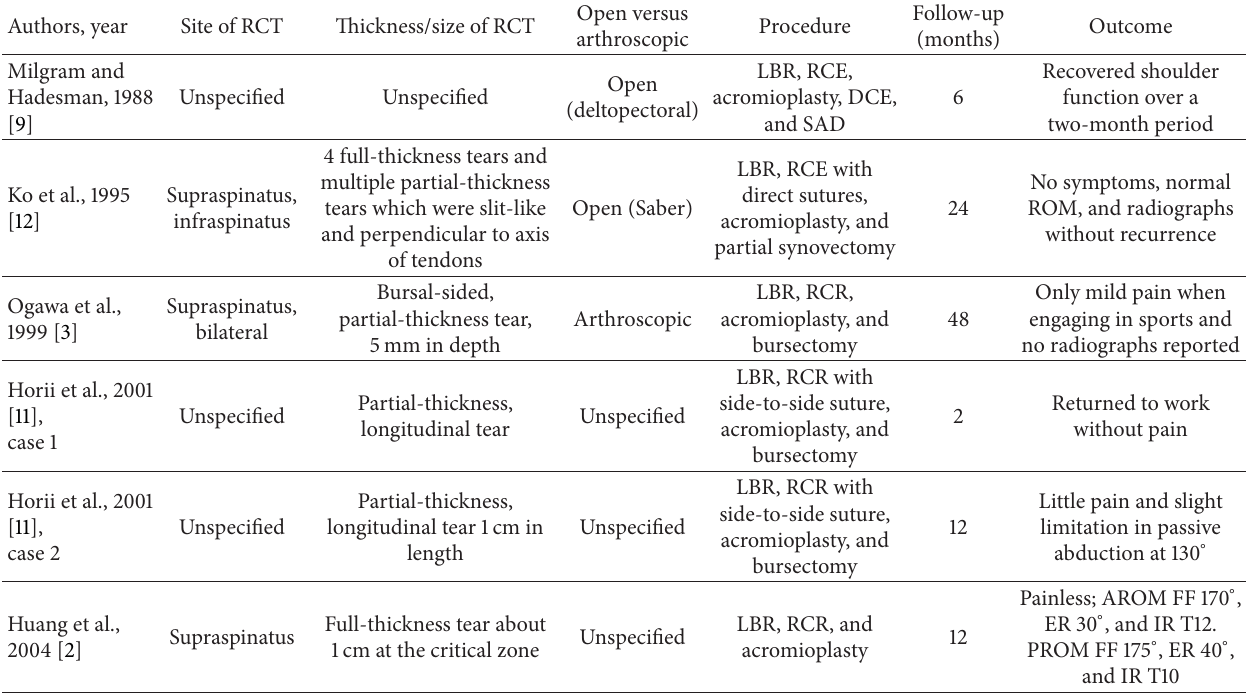
Figure 5: Her range of motion at 24 months postoperatively was 165 degrees in forward flexion (a), 75 degrees in external rotation (b), and T9 in internal rotation. Table 1: Outcomes of bursal-sided rotator cuff tears secondary to